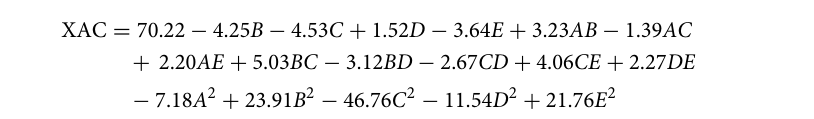
The positive sign in front of the terms indicates a synergistic effect, whereas a negative sign indicates an antagonistic effect 33,36 . Table S1–S4 presented the analysis of variance (ANOVA) of regression of the predicted response from the quadratic models for % Fe content, BAC, TAC and XAC. The calculated F values from the ANOVA (Table S1–S4) for the % Fe content, BAC, TAC and XAC were found to be 96.81, 85.36, 55.63, 61.42 respectively, with lower probability (< 0.0001) indicating that the models were significant. Values presented in Table S1–S4 with “Prob > F” less than 0.05 indicates model terms are significant, whilst the insignificant terms are omitted from the tables. The calculated coefficient of determination (R 2 ) values were 0. 9852, 0.9833, 0.9746, and 0.9769 for the % Fe content, BAC, TAC and XAC respectively which highlights an acceptable accuracy of the datas with the model. The adequacy of the model equation in describing the experimental data was validated from the plot of predicted versus actual values. The relationship between predicted and actual values of % Fe content and BAC, TAC and XAC (mg/g) are indicated in Fig. 1A,D. It is observed that the plots show a high cor- relation between the predicted and actual results indicating, this model can be used to navigate the design space. Effect of preparation variables on % Fe content and BTX adsorption capacity. the responses of the model 37,38 . In Fig. 2, a-3D response surface plots depict the significant interaction between